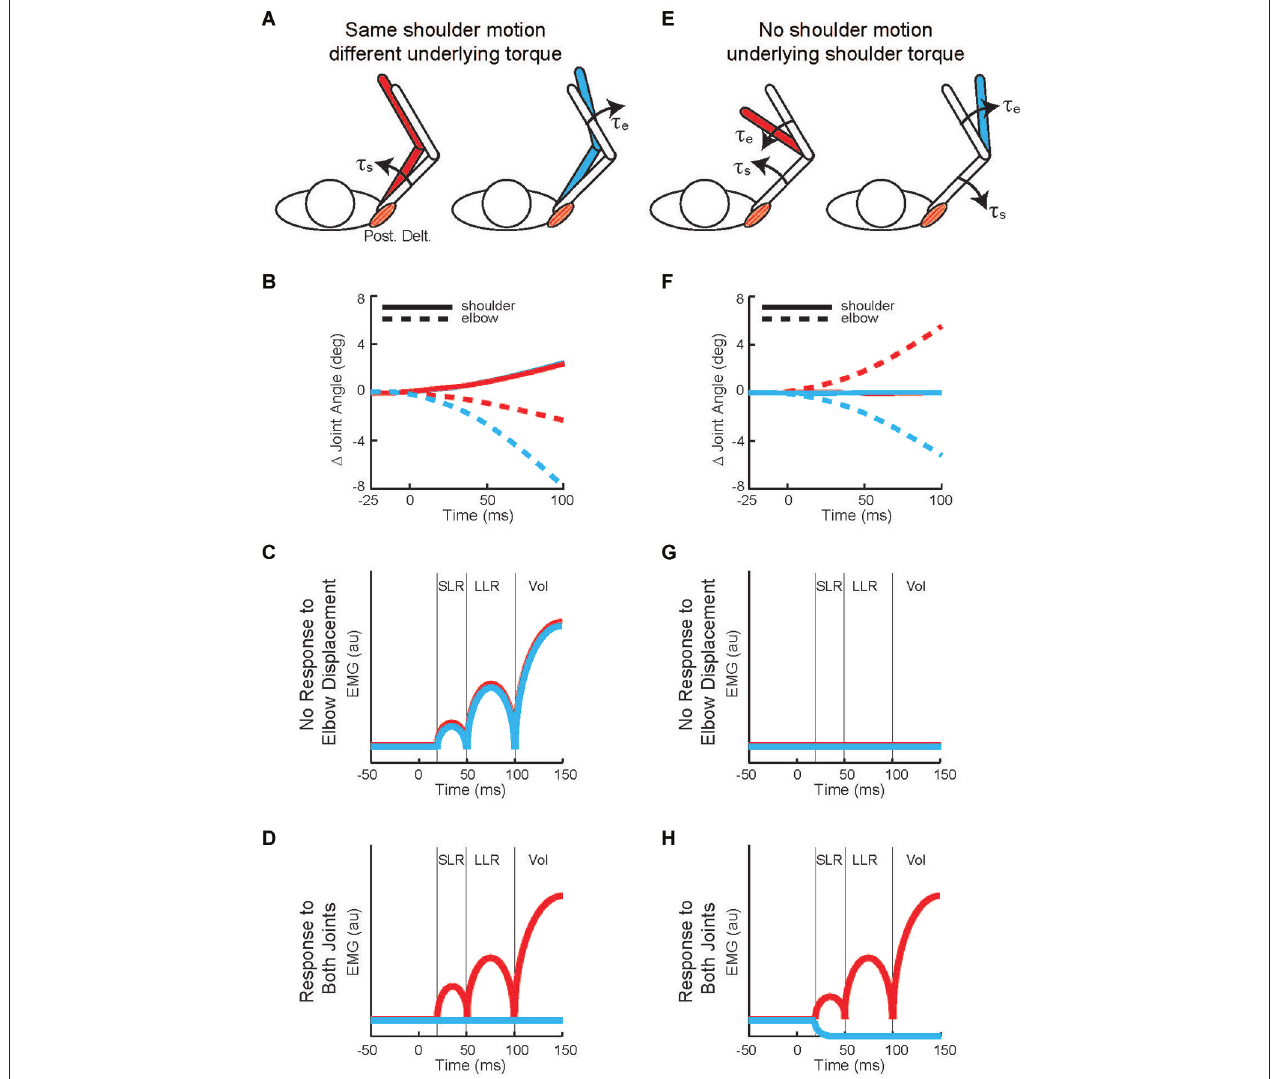
stretch from shoulder and elbow muscles appropriate to counter the underlying torque. (E) Torque perturbations applied to the arm, a shoulder-elbow flexor torque (see the red arm) and a shoulder-elbow extensor torque (see the blue arm). (F) Change in joint angle from the starting posture. Same format as (B) . The initial joint motion is almost entirely restricted to the elbow. (G) Predicted shoulder muscle response to the shoulder torque and elbow torque perturbations if the neural processes only utilized local muscle stretch. (H) Predicted shoulder muscle responses if the neural processes integrated stretch from shoulder and elbow muscles appropriate to counter the underlying torque. (A,B) , (E,F) modified with permission from Kurtzer et al.